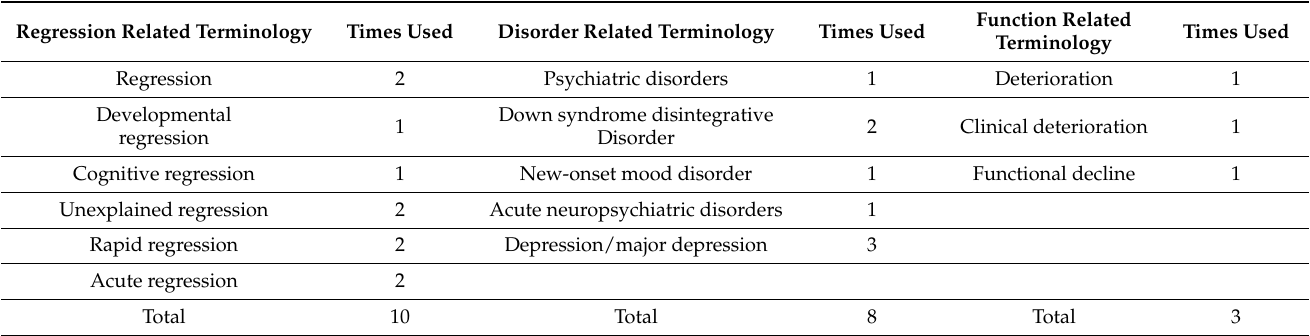
Table 2. List of the terminology used to describe the group of patients within the article. Articles may have referenced multiple